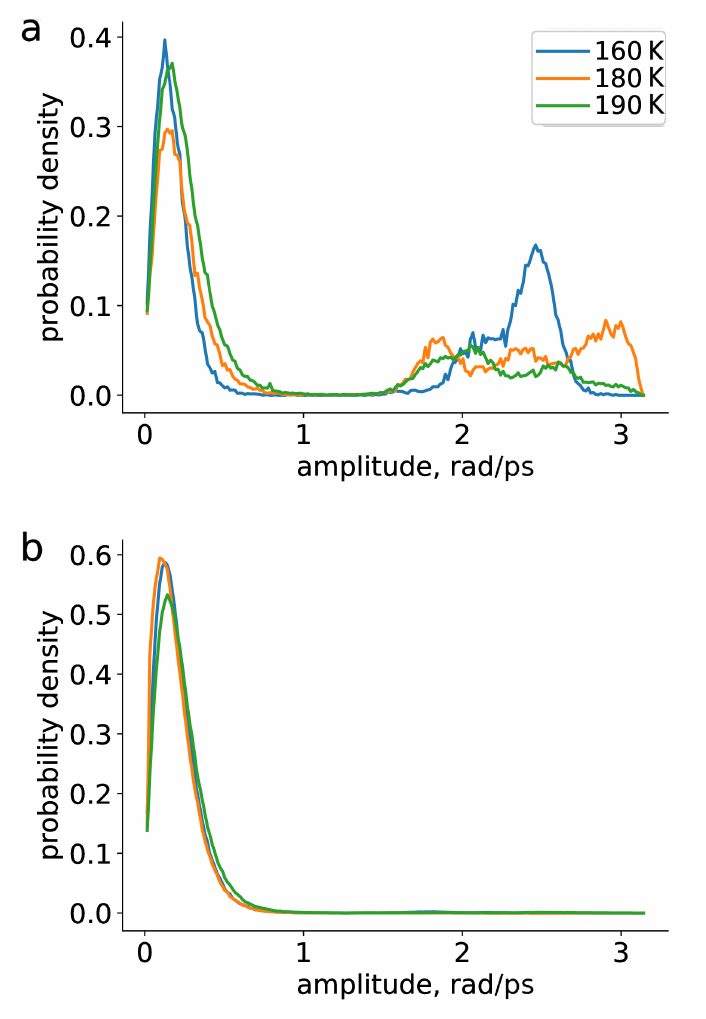
Figure 4. Rotational spectra for mobile ( top ) and immobile ( bottom ) fractions of TEMPO radical with